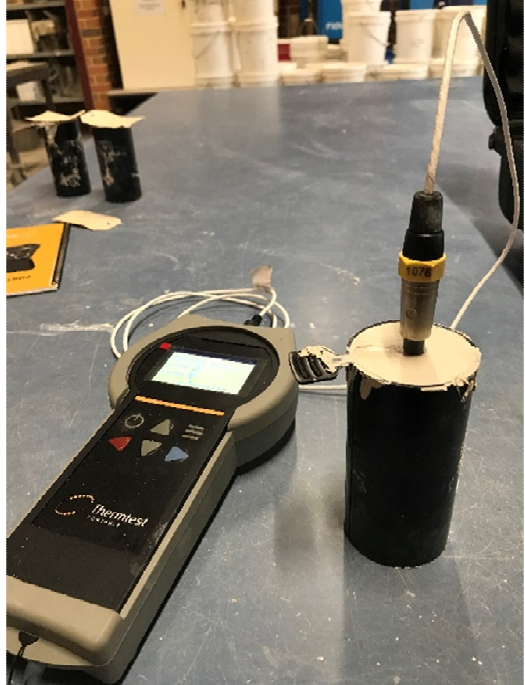
Figure 3. Thermal conductivity test.